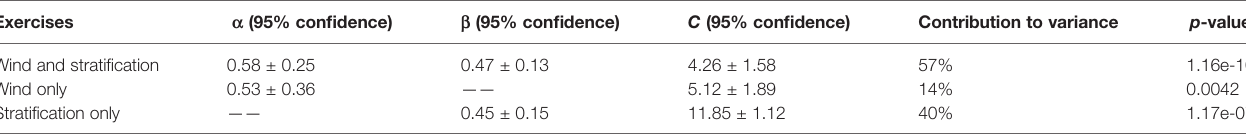
TABLE 2 | The multiple regression results for equation (3) based on observational data in 2019.